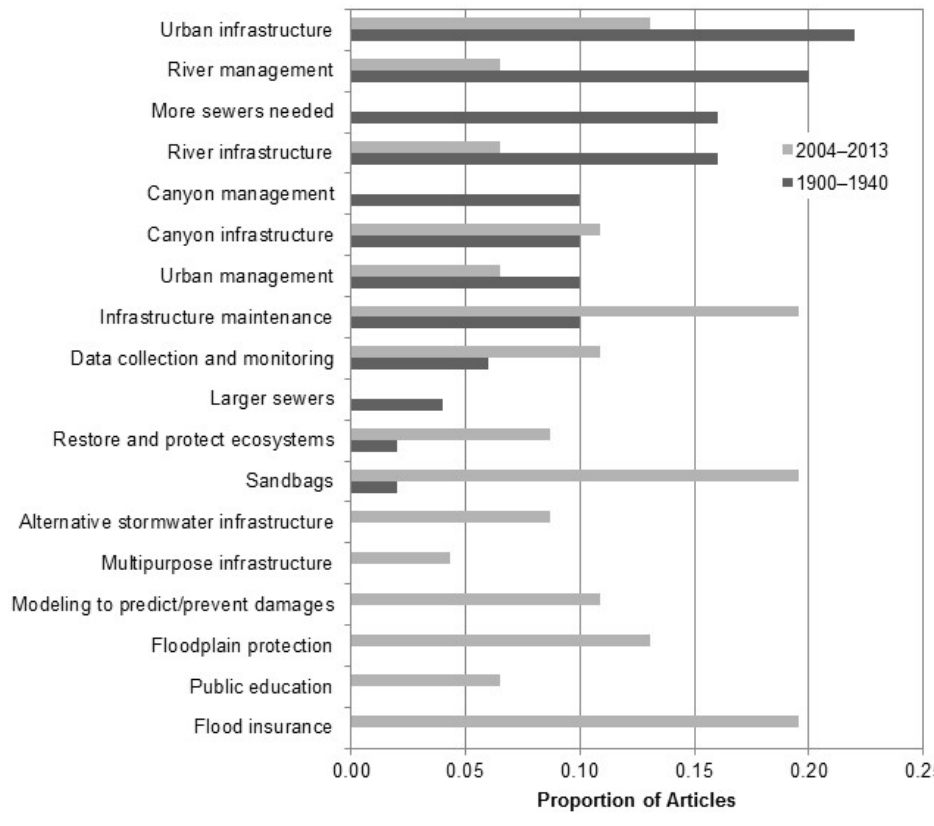
Figure 6. Solutions proposed to address flooding and stormwater during two periods as mentioned in the Salt Lake City news media.